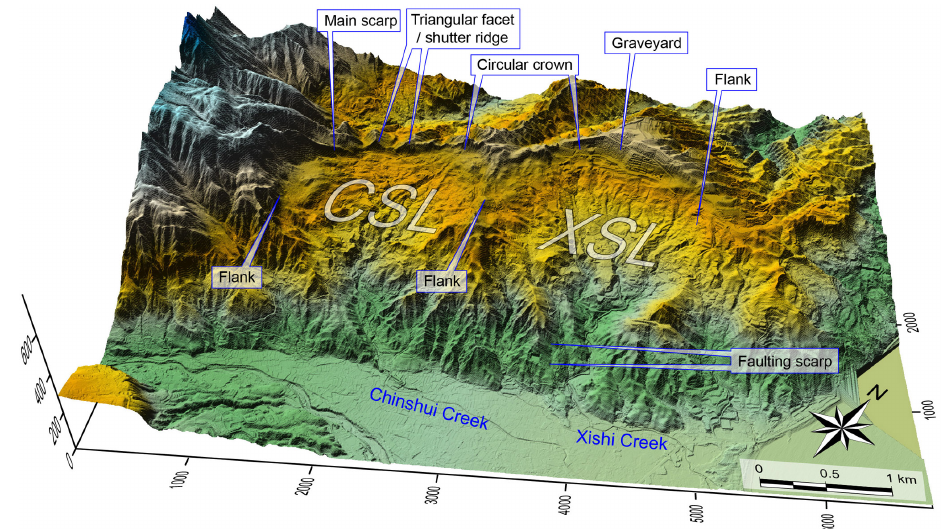
Figure 6. Perspective view of the 3-D hillshade map of the study area from the lidar DTM. The morphological features, namely circular crowns, flanks, main scarps, shutter ridges, and triangular facets, can be observed. However, part of the main scarp in the XSL was signifi- cantly modified as a graveyard (Fig. 3b and c). Only part of the depletion zone was preserved on the two main landslides. In the CSL, clearer topographic features of the sliding process were preserved, possibly indicating that the CSL is newer than the XSL. The location of this figure is indicated in Fig.